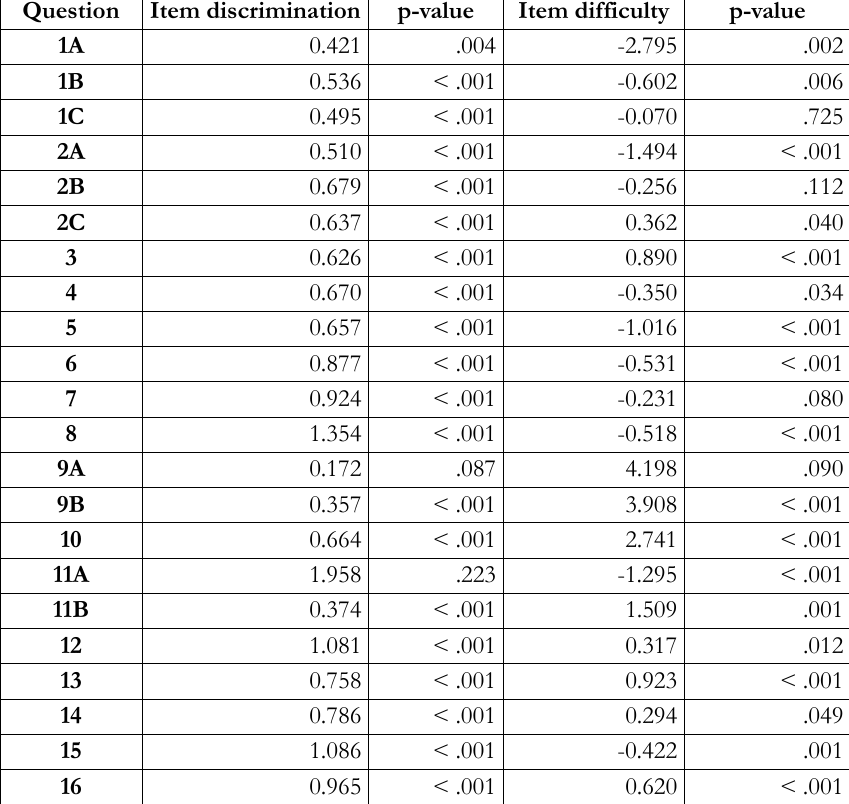
Table 3. IRT parameterisation of the